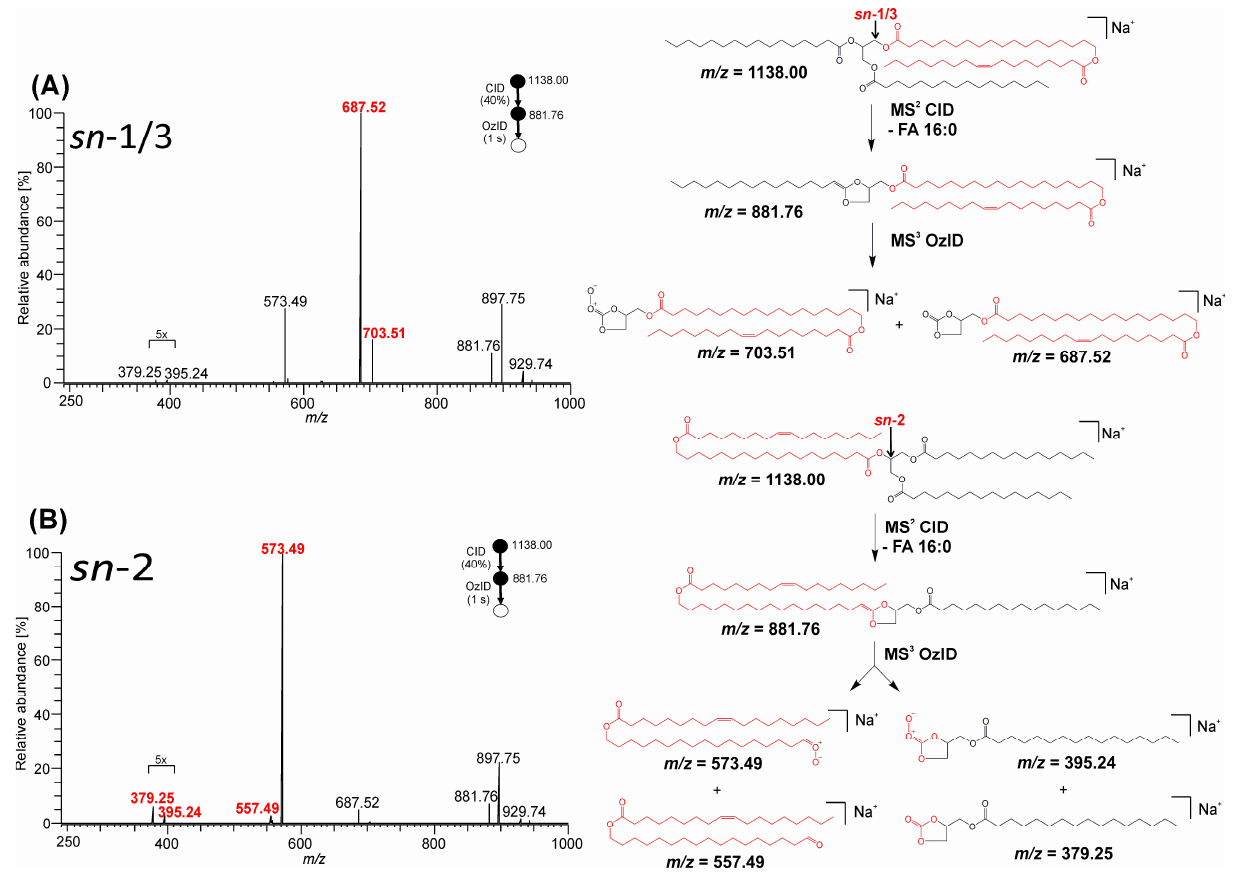
Figure 8. MS 3 CID/OzID spectra of TG ‐ EST [M + Na] + . The CID product ion at m/z 881.76 corresponding to neutral loss of palmitic acid was re ‐ isolated and allowed to react with ozone: ( A ) TG ‐ EST 7 — sn ‐ 1/3 ‐ isomer; ( B ) TG ‐ EST 8 — sn ‐ 2 ‐ isomer. Diagnostic product ions for the various positional isomers are highlighted in red. Selected product ion abundances were magnified, as indicated.